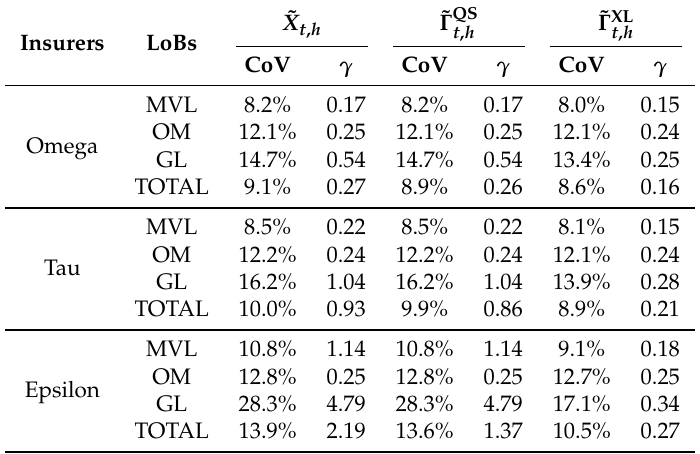
Table 9. CoV and skewness of simulated distribution for each LoB (Liabilities oriented Portfolio Mix).